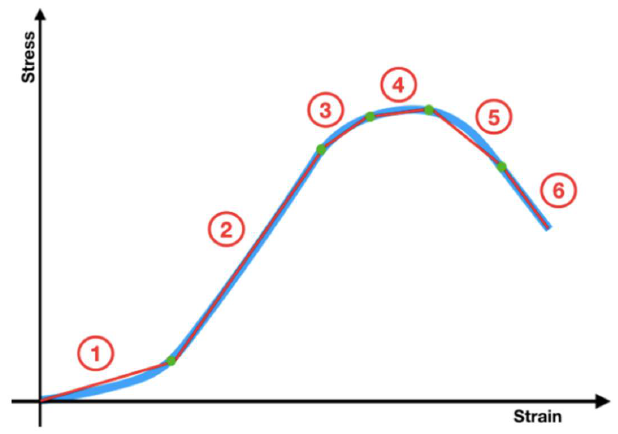
Figure 4. Stress–strain curve defining the segmented linear regression lines into which the curve can be broken down. Number 2 shows the slope of the last segment before it reached the proportional limit compared to the previous one.